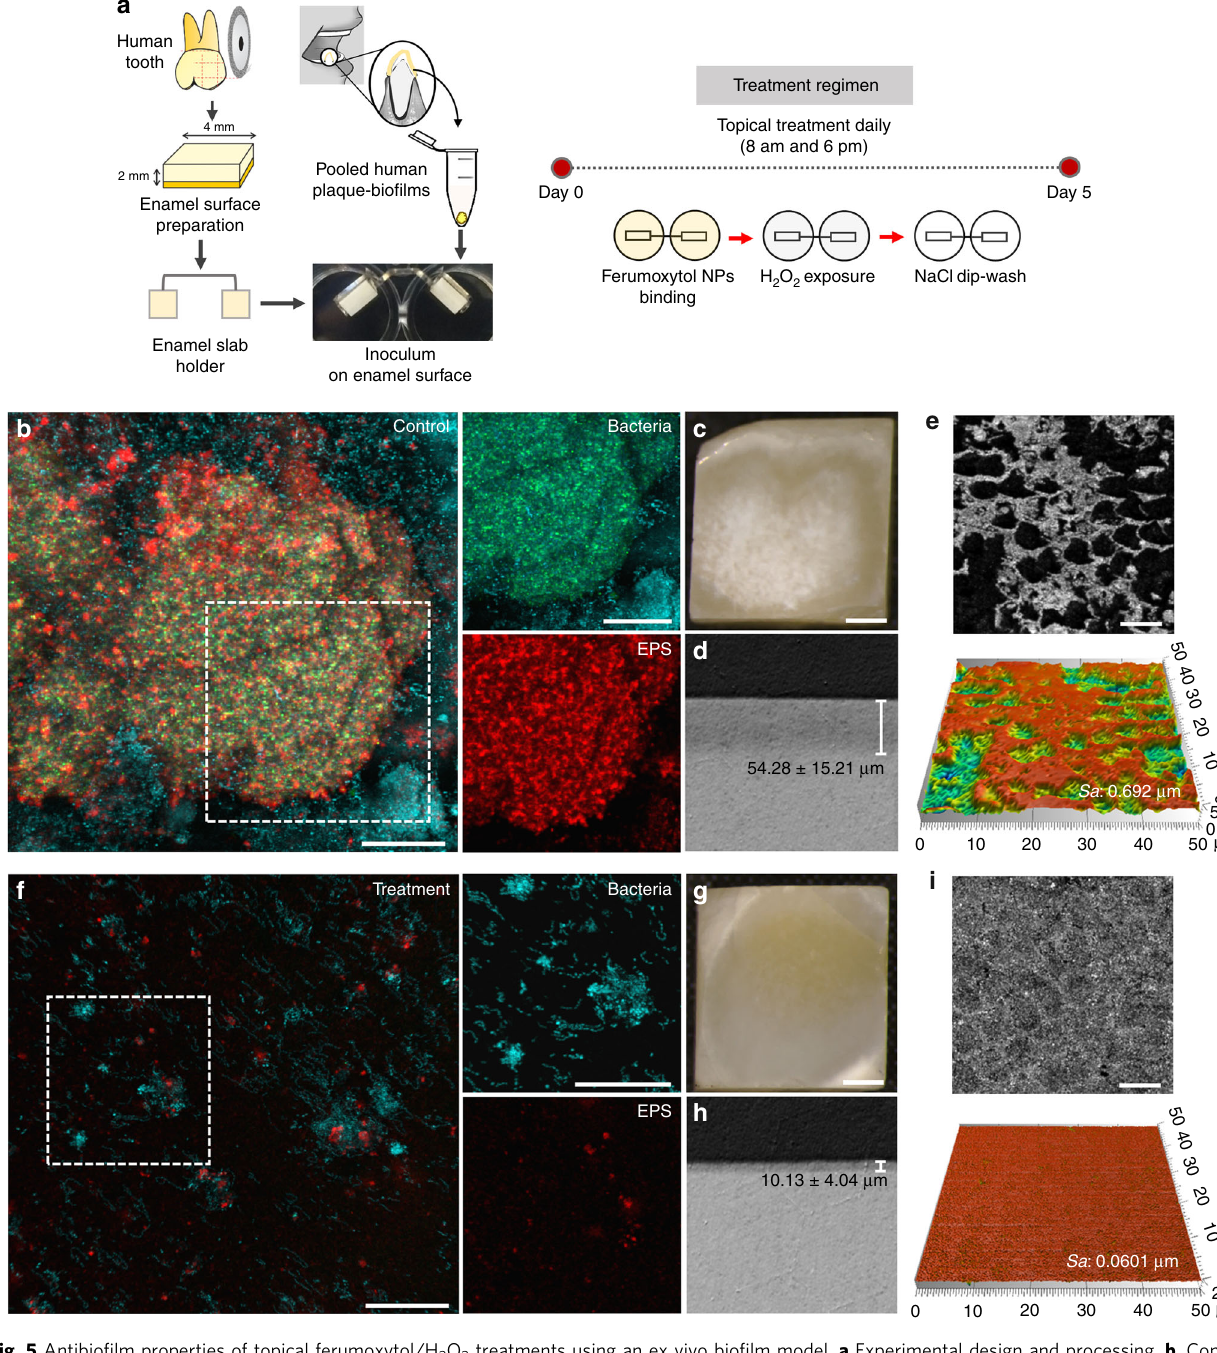
Fig. 5 Antibio fi lm properties of topical ferumoxytol/H 2 O 2 treatments using an ex vivo bio fi lm model. a Experimental design and processing. b , Confocal imaging of the morphology of vehicle-control treated bio fi lm and f bio fi lm treated with ferumoxytol/H 2 O 2 (white box indicates selected area for close-up images of bacteria and EPS components; Scale bar: 50 µ m): total bacteria and S. mutans cells are labelled in blue and green, respectively; EPS are in red (Scale bar: 50 µ m). c , Light microscopy images of the enamel surface of untreated bio fi lm showing “ white spot-like caries lesions ” and g ferumoxytol/H 2 O 2 treated bio fi lm showing intact and smooth surface (Scale bar: 1 mm). d , h Lesion depth of the enamel surfaces (control and treated). e , i Representative confocal topography of enamel surfaces and enamel roughness (control and treated) (Scale bar: 10 µ m). The data presented as mean ± s.d. from triplicates of two independent experiments ( n =